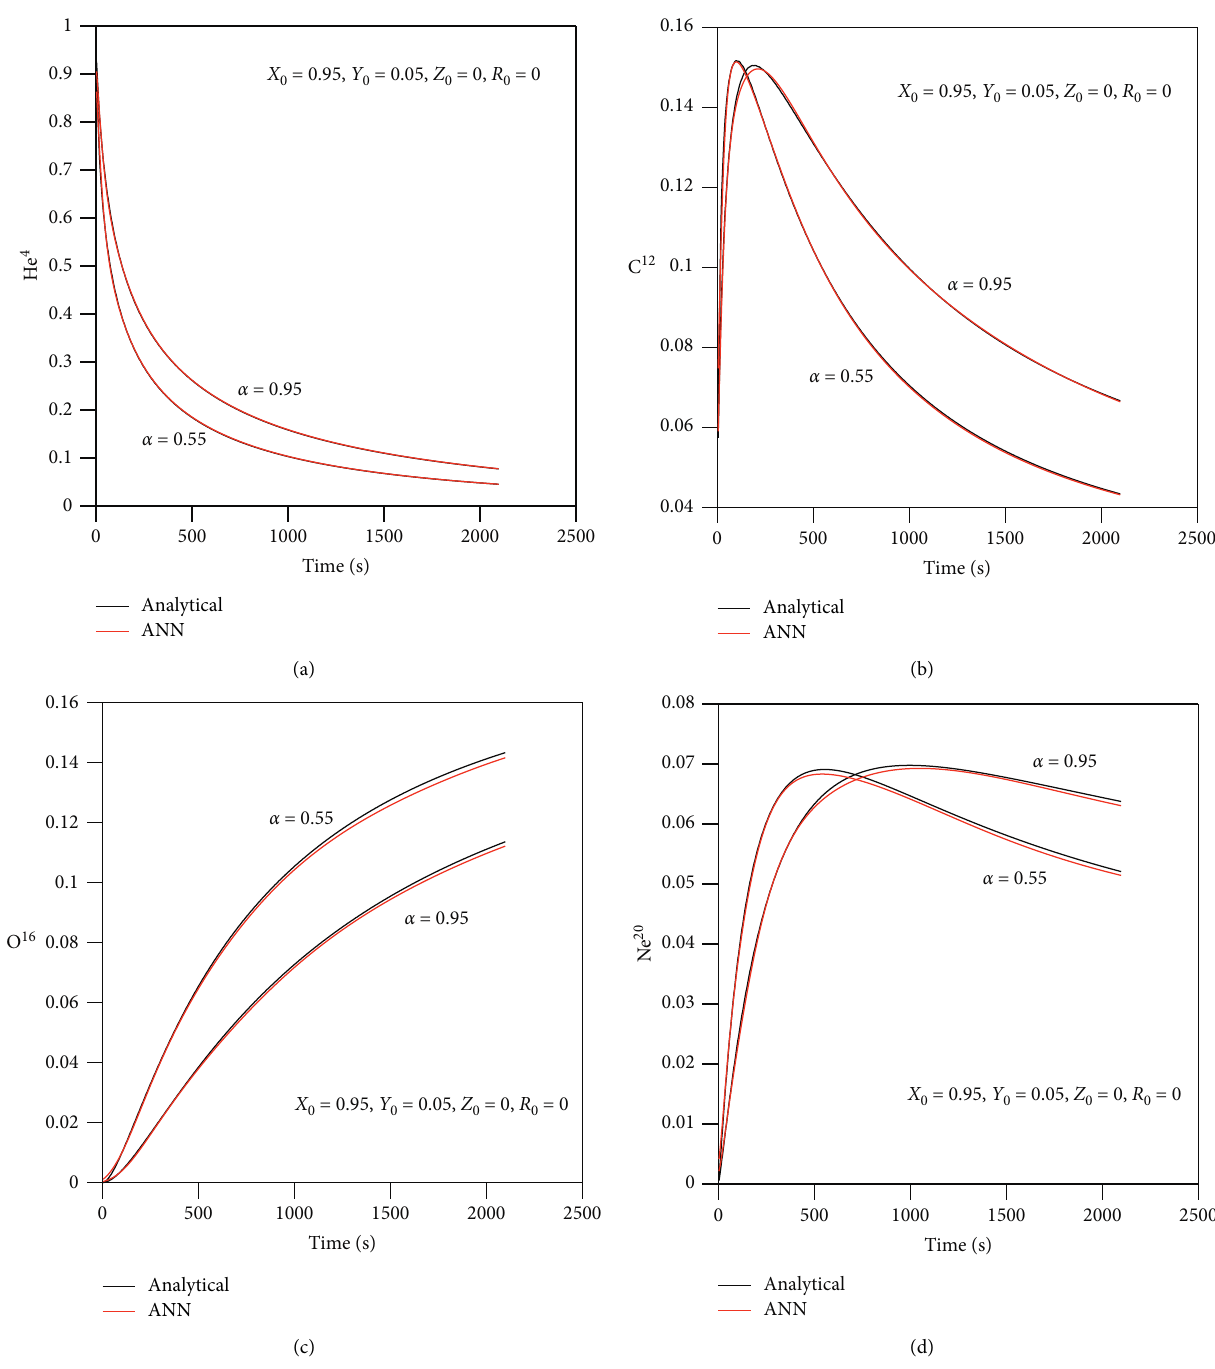
Figure 8: The distribution of the product abundance with time for the rich helium burning network, X R 0 �